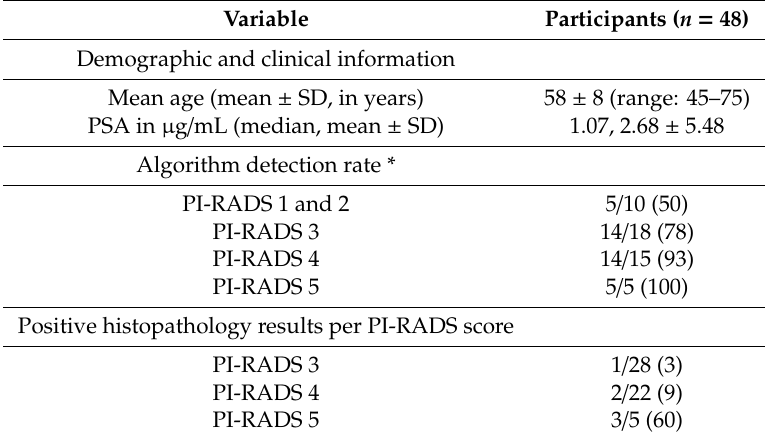
* Data represent results on a case level with counts for PI-RADS 3, 4, and 5 categories representing the index lesion score per patient and nested PI-RADS 1 and 2 categories if no or clearly benign lesions were reported. Values in parentheses are percentages. Table 3. Algorithm performance on a case and lesion